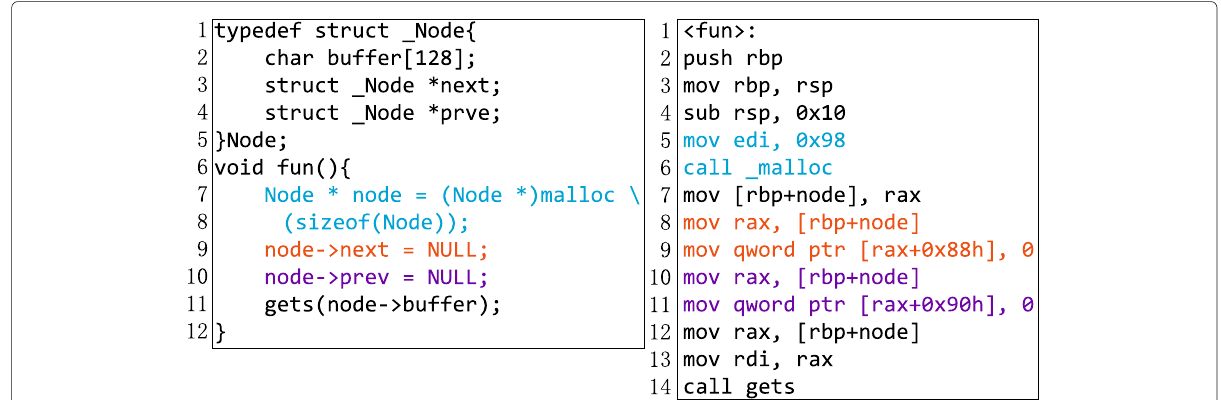
Fig. 4 The source code and assembly code of the linked list example